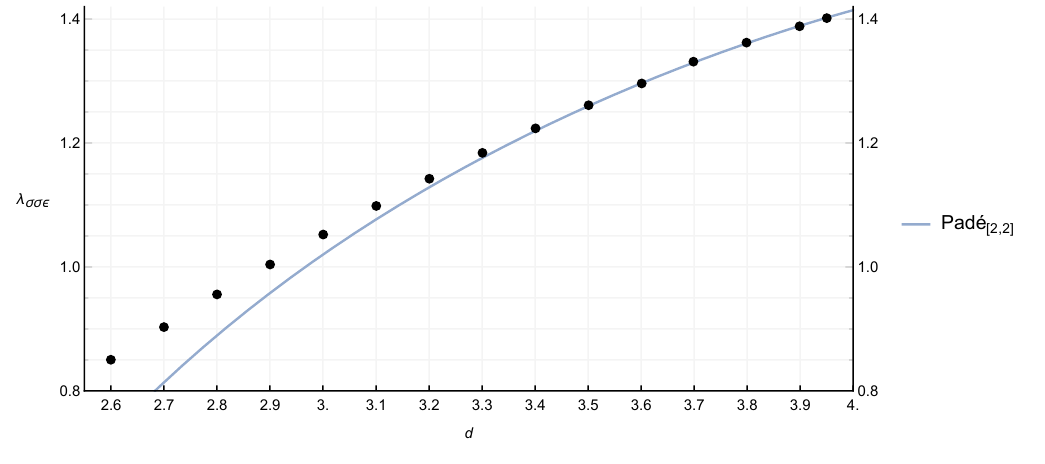
Figure 18 . OPE coefficient λ